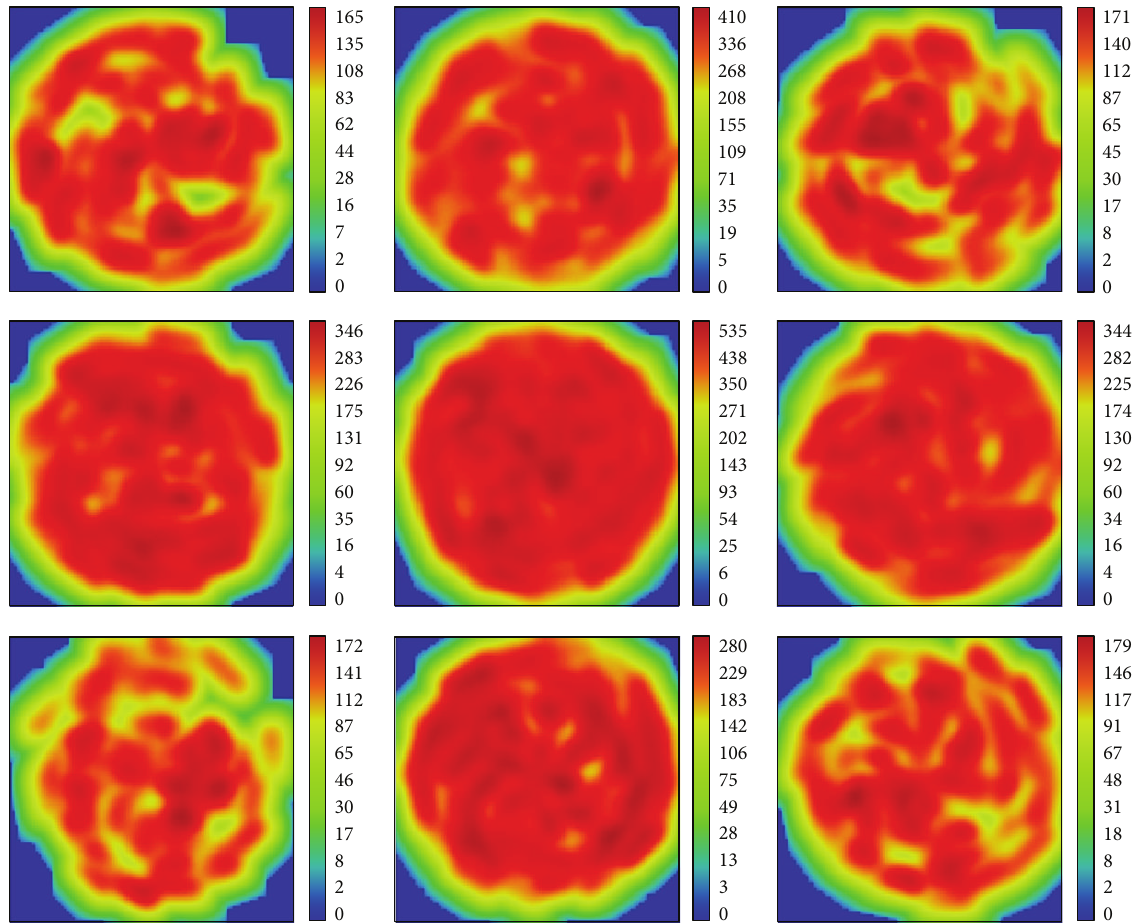
Figure 13: Distribution of radiant intensity for CTPCs according to their